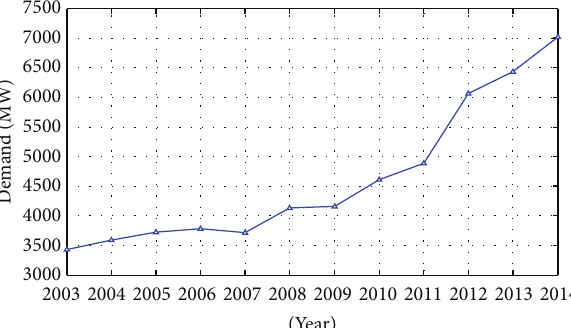
Figure 4: Increase of energy demand over different years.